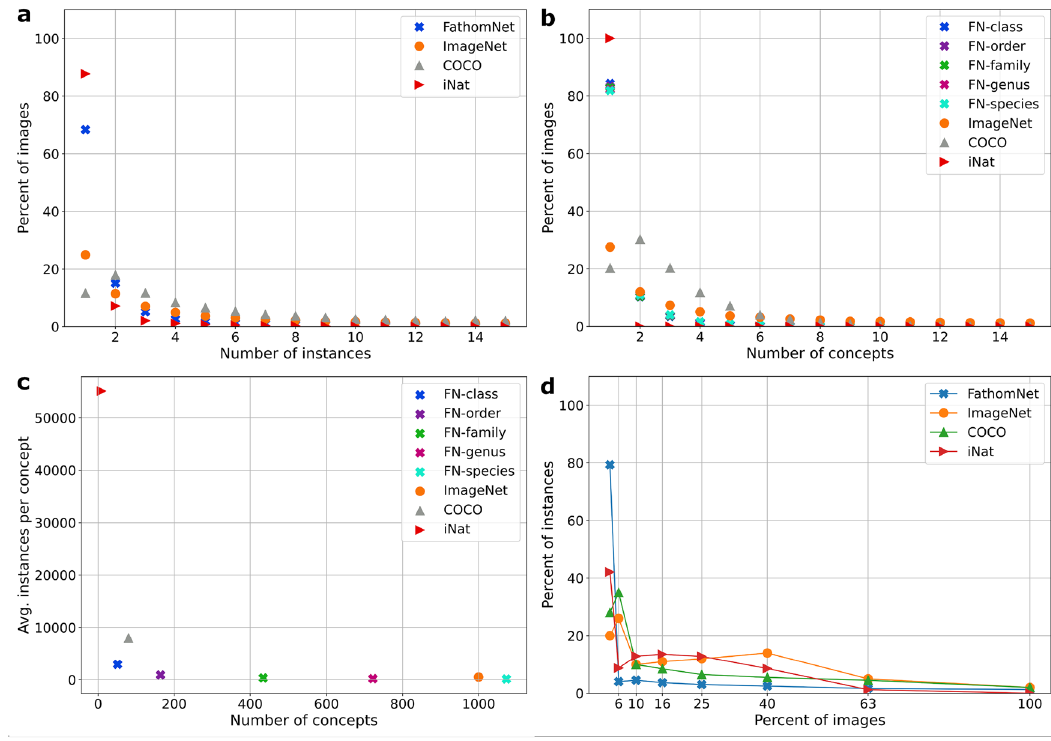
Figure 4. Dataset statistics contextualizing FathomNet relative to COCO, ImageNet, and iNat2017. Statistics for COCO were computed from the 2014 training split, ImageNet numbers were generated from the 2015 localization data split, and iNat2017 metrics were derived from the 2017 training data. ( a ) Percent of images containing a number of instances, or localizations. ( b ) Percent of images displaying a given number of concepts. FathomNet annotations are displayed broken down at different levels of taxonomic rank. ( c ) The average number of instances versus the average number of concepts over the entirety of each dataset. ( d ) The distribution of relative instance size. Most objects in FathomNet and iNat are small compared to ImageNet and